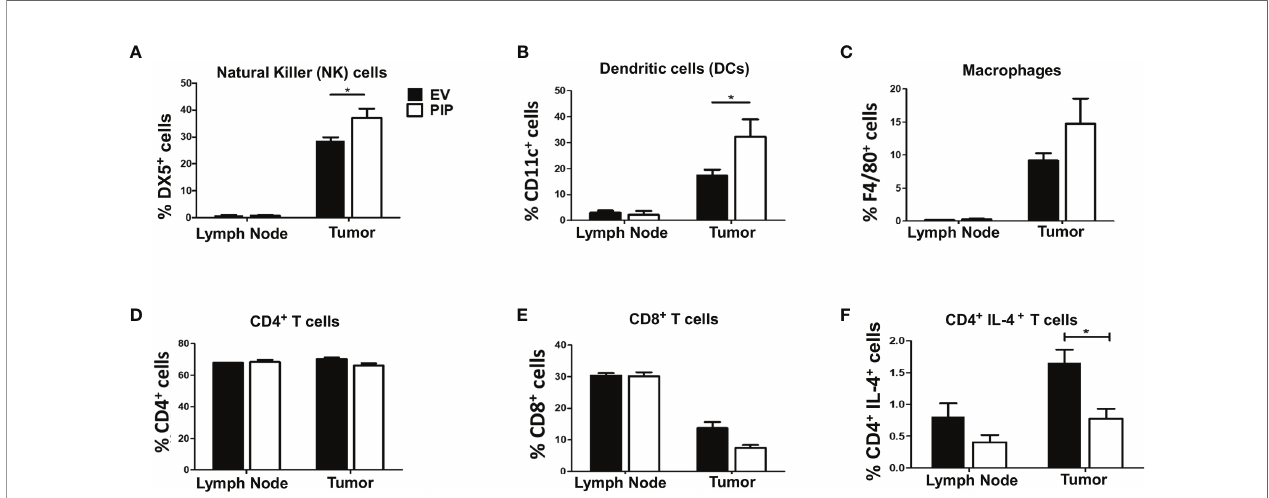
FIGURE 4 | Expression of PIP gene by 4T1 tumor cells is associated with increased frequency of natural killer (NK) and dendritic cells and decreased CD4 + IL-4 + T cells in tumor in fi ltrating cells. BALB/c mice were injected with PIP expressing 4T1 cells (PIP) and controls (EV) and after 14 days, mice were sacri fi ced and the percentage of NK cells (DX5 + ), (A) , dendritic cells (CD11c + ), (B) , macrophages (F4/80 + ), (C) , CD4 + (D) and CD8 + (E) T cells, in the draining lymph nodes and tumors were assessed by fl ow cytometry. Some cells were stained directly ex vivo , and the frequency of IL-4-secreting CD4 + T cells was assessed by fl ow cytometry (F) . Results are representative of three different experiments. Results are expressed as mean ± SEM of n = 4 – 5 mice/group. *p < 0.05; two-way ANOVA was